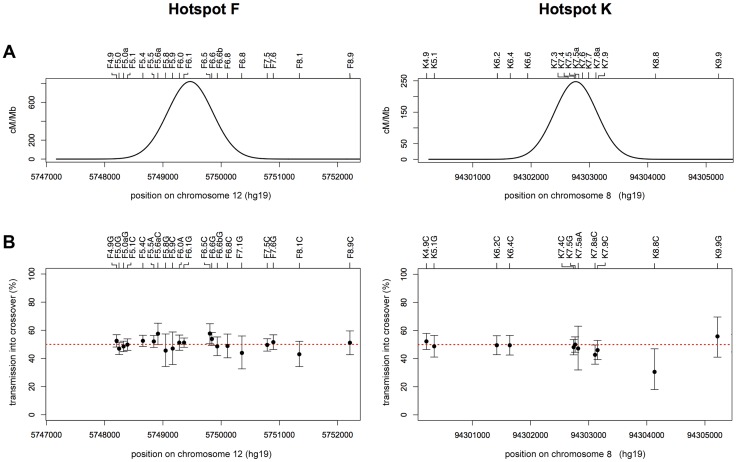
No evidence for CO asymmetry.(A) Least-squares best-fit normal distribution of reciprocal A+B COs for all men combined at hotspot F (left) and hotspot K (right). (B) Transmission frequencies of SNP alleles into reciprocal A+B COs, with 95% CIs calculated by Bayesian analysis. Transmission of the strong allele (C or G) is shown for transition polymorphisms, and transmission of the purine allele is shown (A or G) for transversion polymorphisms. Data for the hotspot F region are derived from all 10 men analysed since they are all heterozygous at SNP F6.1 (left), whilst those for the hotspot K region are from the 8 men heterozygous for SNP K7.4 (right). The two alleles at each of the 20 markers in and around hotspot F show parity in transmission to COs as determined by two-tailed exact binomial tests (all P values>0.05, without Bonferroni correction). Of the 11 markers analysable in the hotspot K region, only the alleles at K8.8 showed deviation from 50% transmission (P = 0.029, two-tailed exact binomial). The disparity at this marker, which is located outside of the hotspot and informative in just 1 man, is not significant if a Bonferroni correction is applied (P = 0.319).